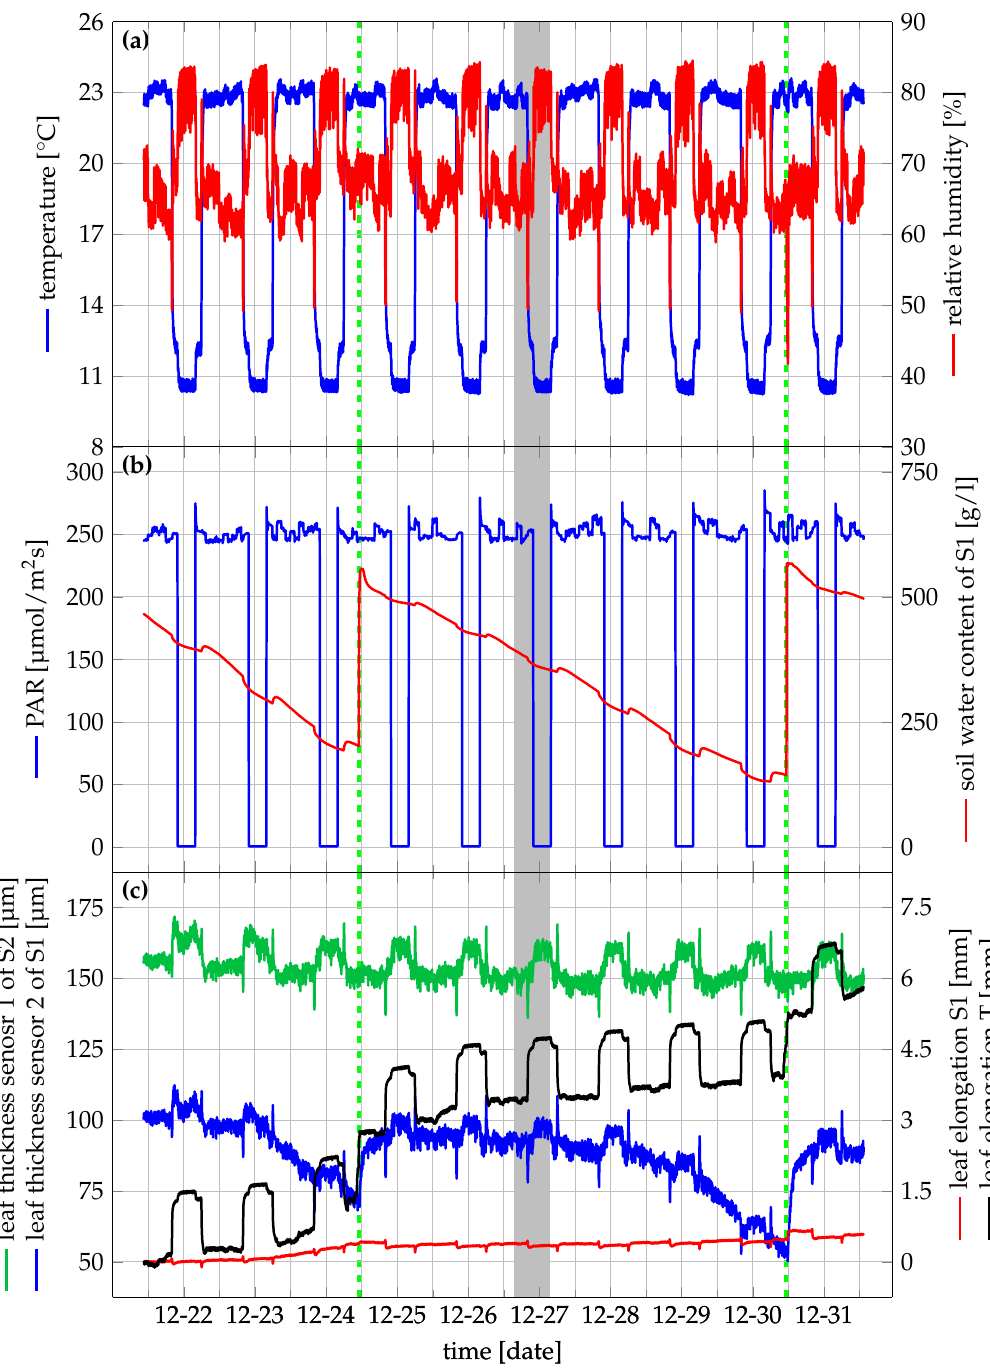
Figure 5. Visualisation of the captured data in a growth chamber experiment with a strawberry plant. The dashed green line indicates the watering time point. A detailed figure of the grey shaded line (16:30 on 26 December to 3:30 on 27 December) is depicted in Figure